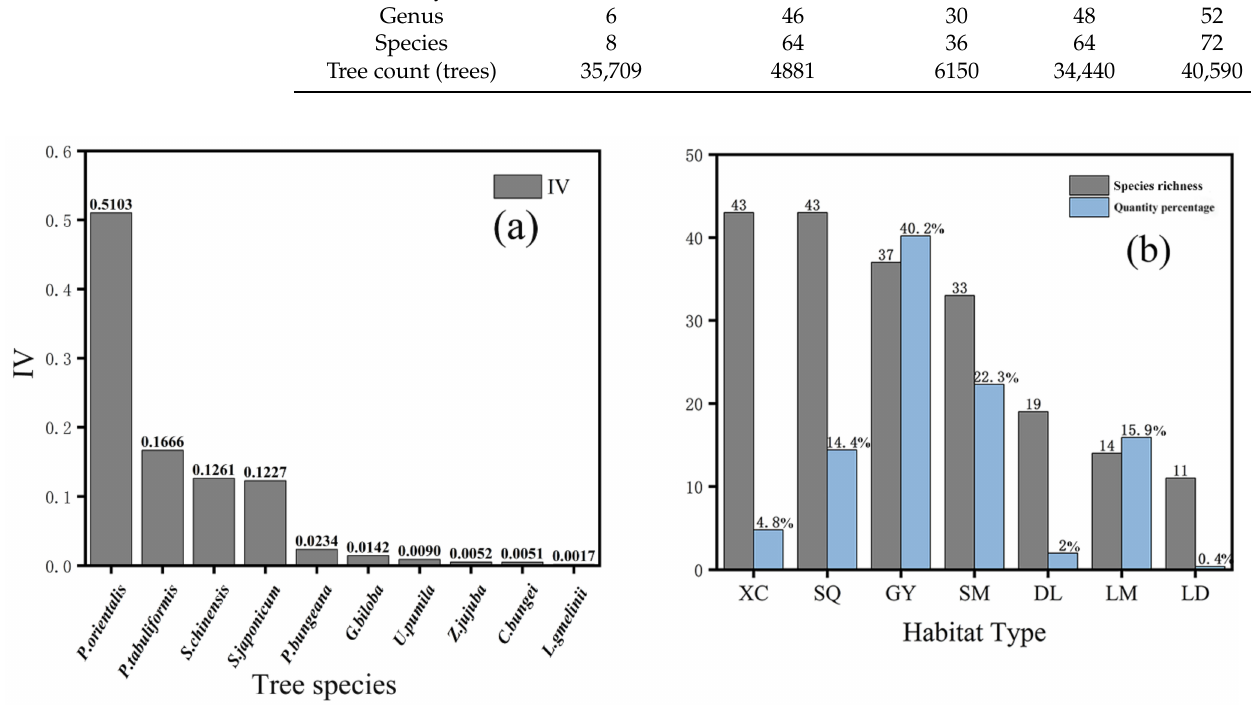
Figure 2. Statistical map of the distribution of the top ten tree species ( a ) and habitats with importance values of large old trees in Beijing ( b ) Remarks: (GY: park, LM: cemetery, SQ: community, SM: temple, DL: roadside, LD: microgreen space, and XC: